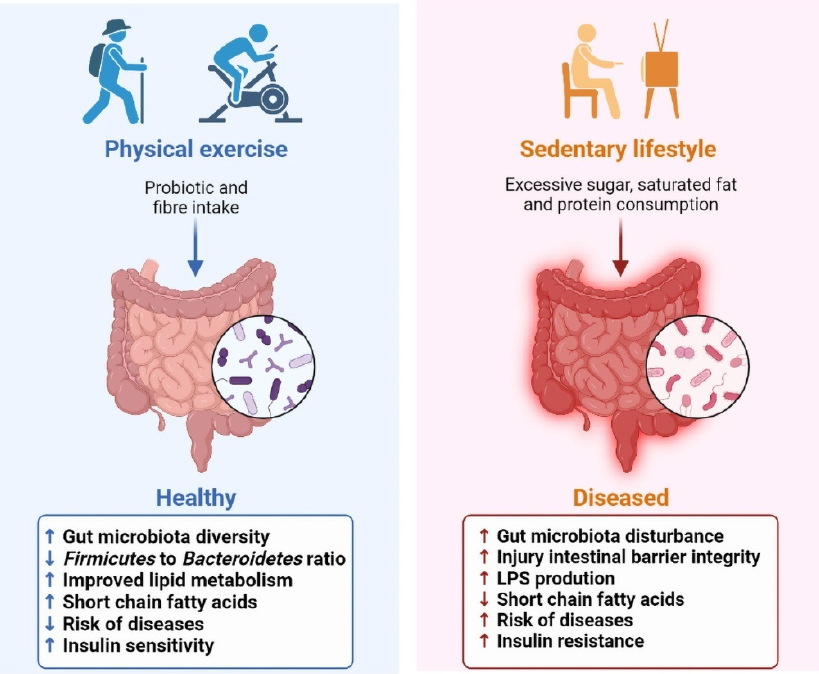
Figure 1. Effect of physical exercise on gut microbiota and host health.